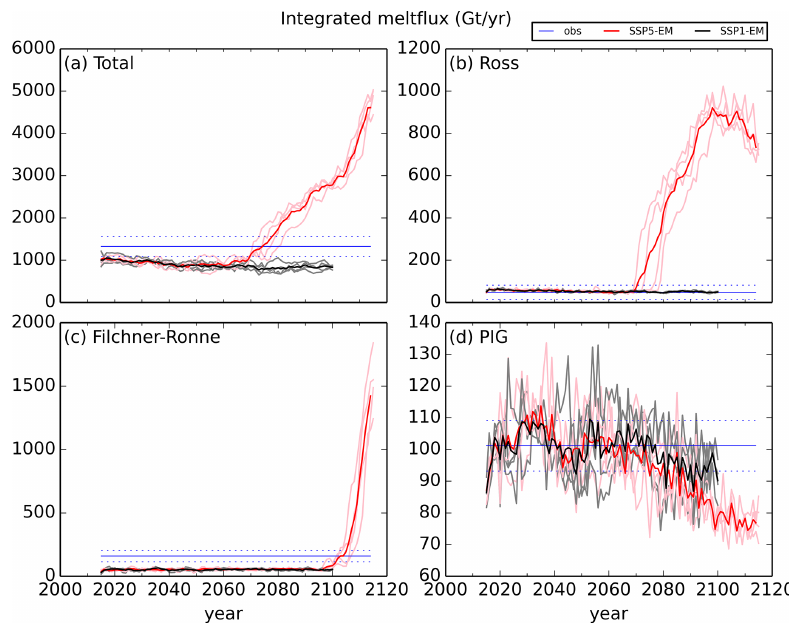
Figure 7. Time series of melt flux (Gtyr − 1 ) under Antarctic ice shelves. Pink lines are SSP5–8.5 ensemble members, and grey lines are SSP1–1.9 members. The red and black lines are the ensemble mean of SSP1–1.9 and SSP5–8.5, respectively, and the blue lines are from Rignot et al. (2013) observations, with the solid and dashed line style representing the mean and uncertainty limit,